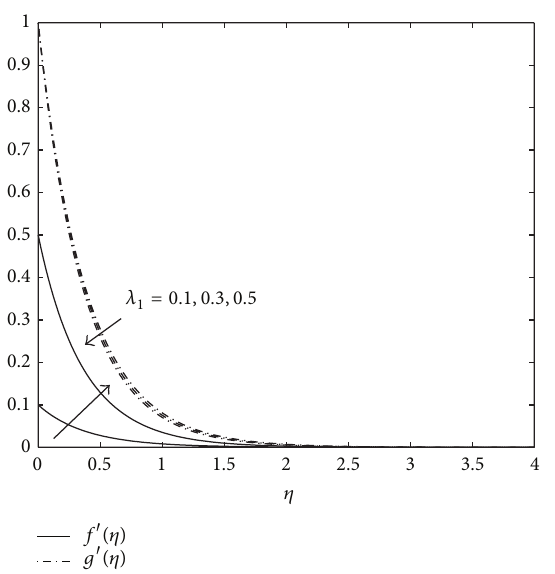
Figure 7: Velocity profiles for different values of 𝜆 1 when 𝜆 2 = 1 .